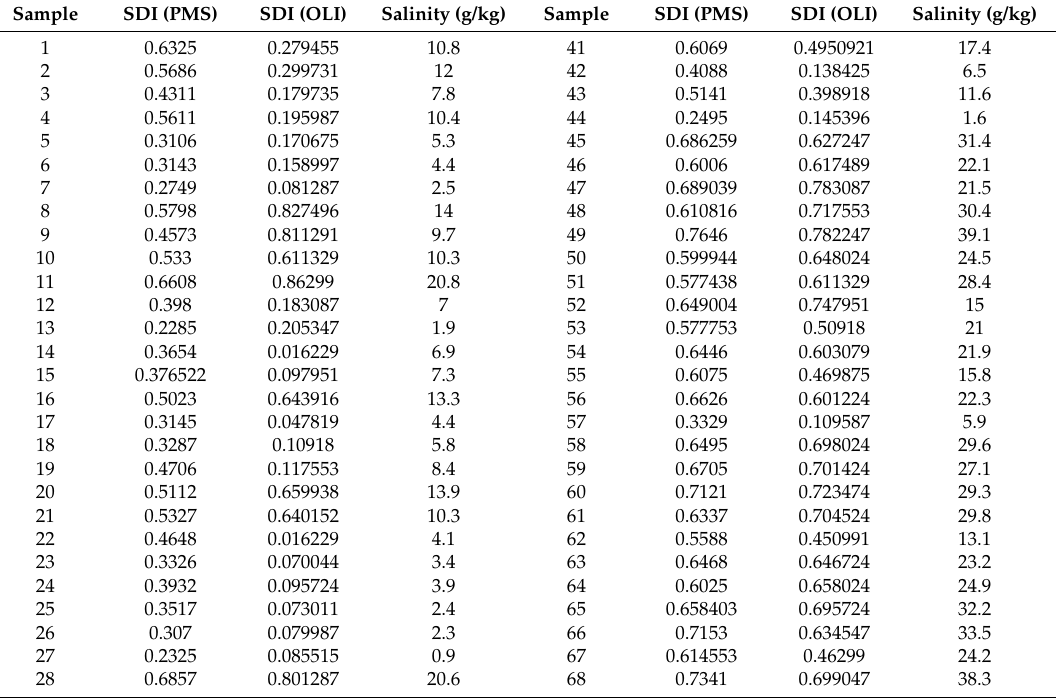
Table 2. Salinization monitoring index (SDI) and soil